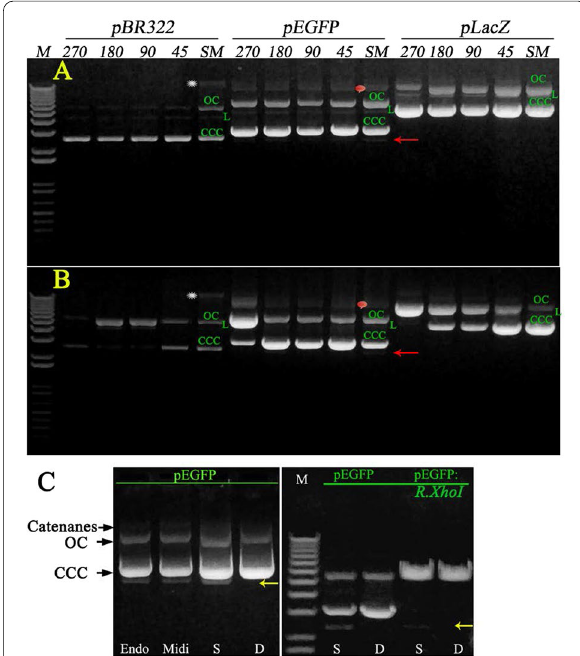
Table 1 Time efficiency of devise-mediated vs